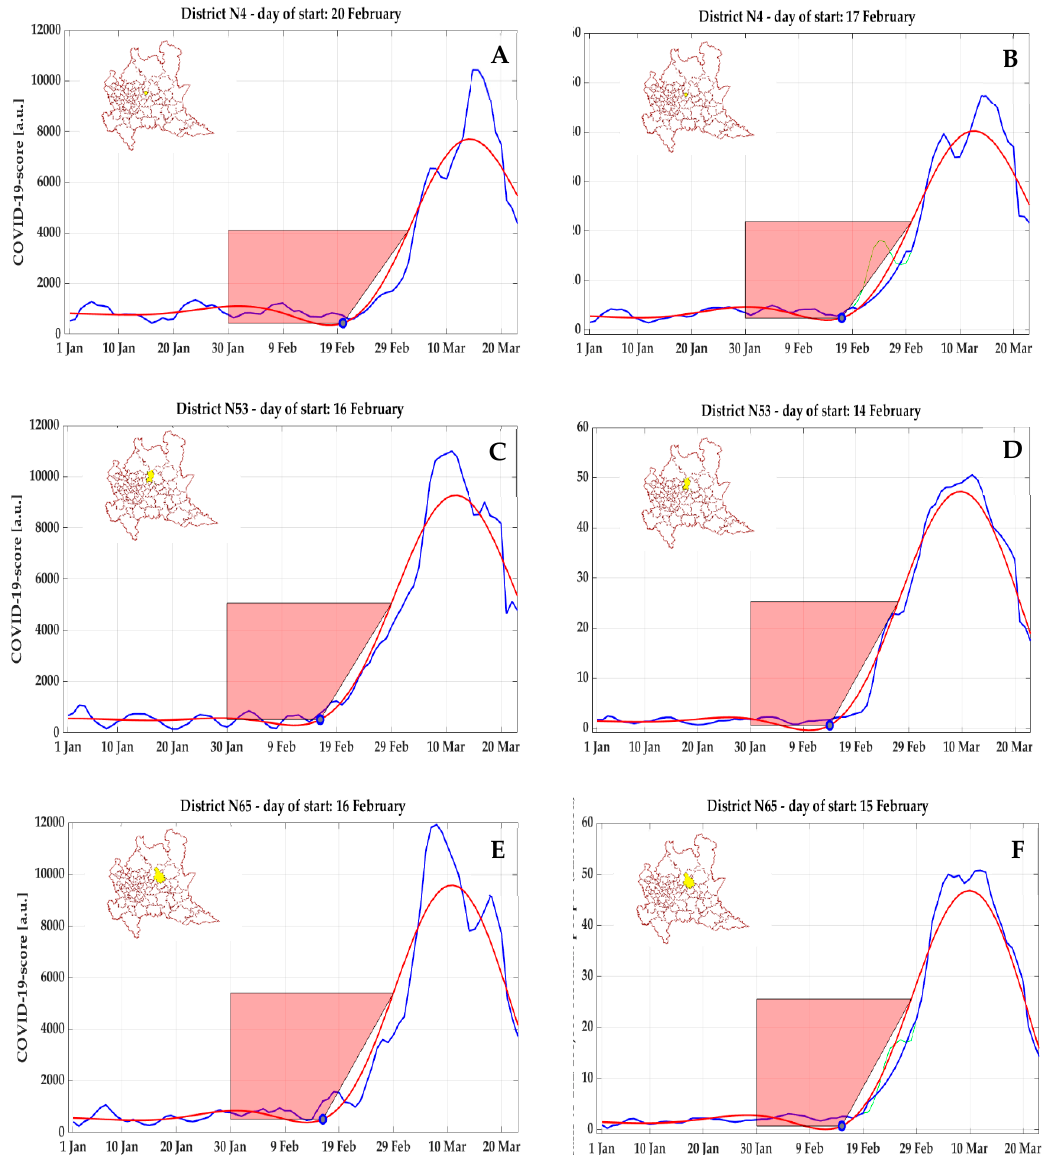
Figure 11. For the cluster including Bergamo (#4): ( A ) COVID-19-score time series with identified inflection point (blue dot, see text for details); ( B ) normalized emergency calls (NEC, N calls/100,000 residents) time series with identified inflection point. For the cluster including Nembro (#53): ( C ) COVID-19-score time series with identified inflection point (blue dot, see text for details); ( D ) normalized emergency calls (NEC, N calls/100,000 residents) time series with identified inflection point. For the cluster including Alzano Lombardo (#65): ( E ) COVID-19-score time series with identified inflection point (blue dot, see text for details); ( F ) normalized emergency calls (NEC, N calls/100,000 residents) time series with identified inflection point. These two peripheral clusters showed an earlier starting day and reached higher peak values than the urban area of Bergamo.